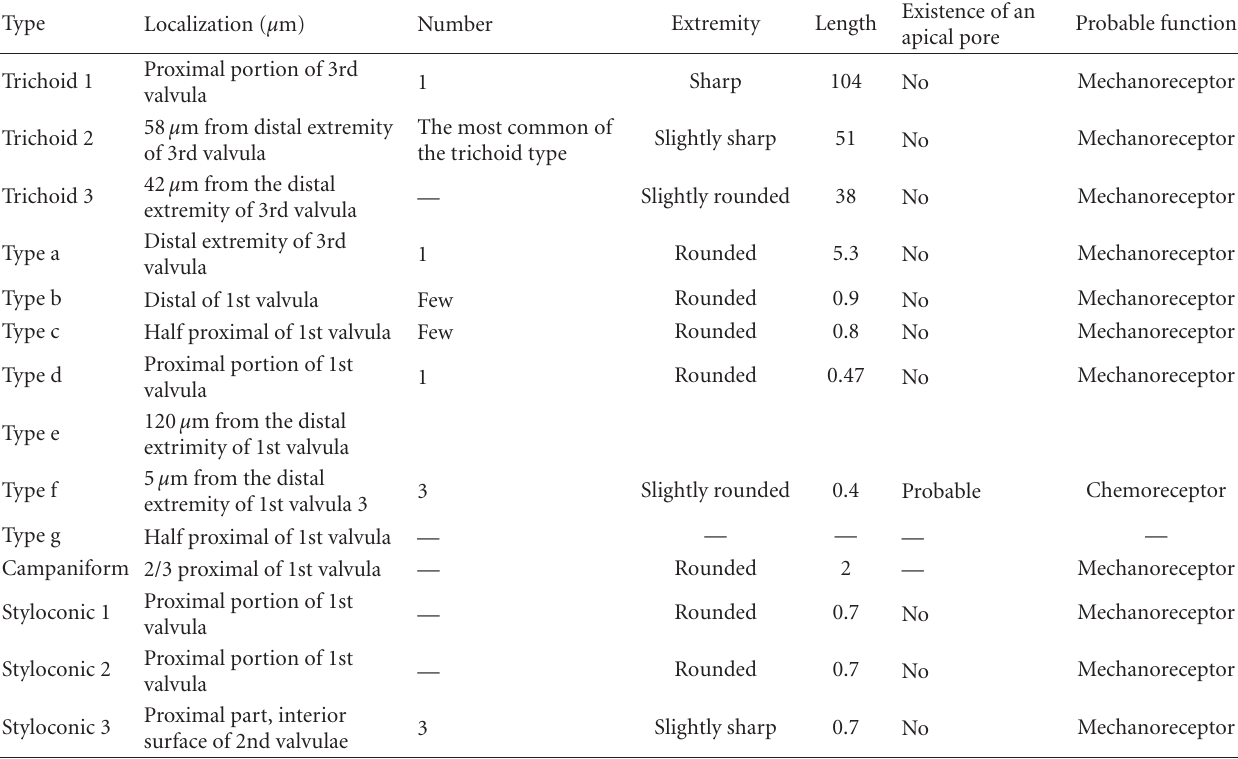
Table 2: Distribution of the sensillae on the ovipositor of A. procerae .